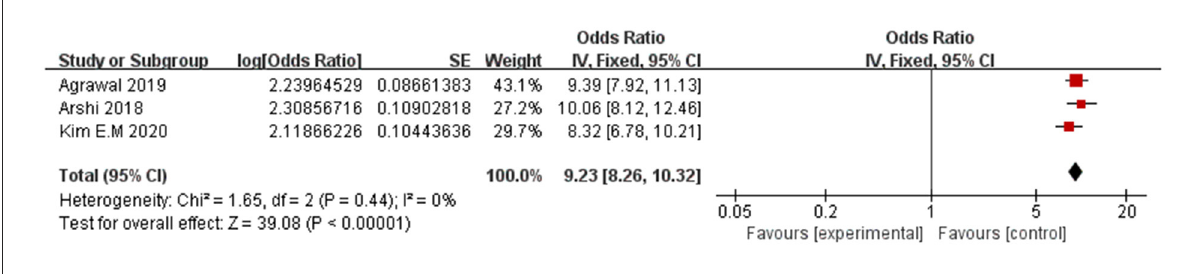
FIGURE8 Forest plot for preoperative delirium.